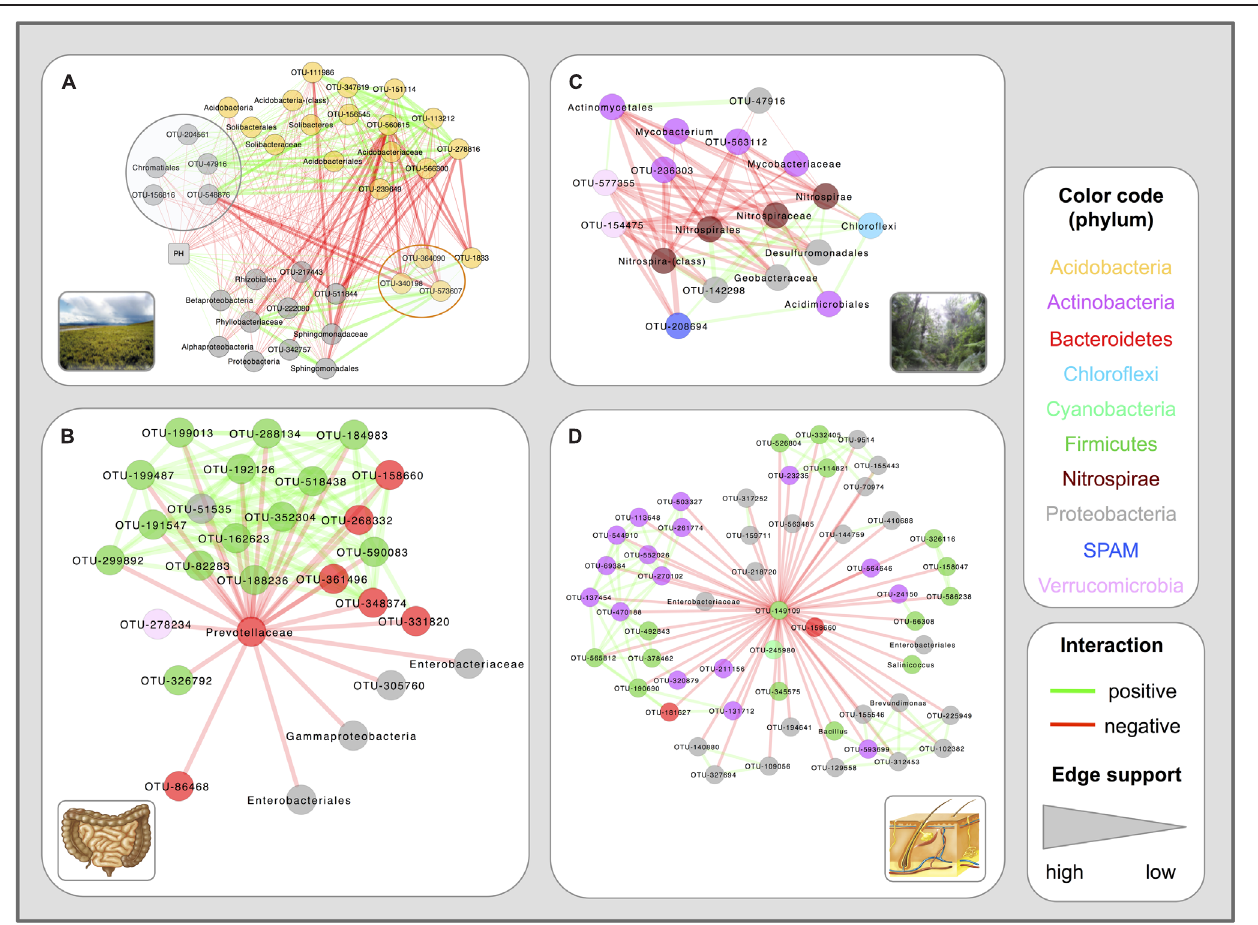
FIGURE 1 | Example networks constructed from QIIME 16S data. Four sub-networks, i.e. node and edge sub-sets from the inferred networks, are shown. The tundra sub-network (A) is dominated by two mutually exclusive clusters consisting of Acidobacteria and Alphaproteobacteria, the first of which is anti-correlated and the second correlated to pH. Notable exceptions to this trend are the Chloracidobacteria (a class within the Acidobacteria, here highlighted with an orange circle) which are positively correlated to pH, and several Rhizobiales (Alphaproteobacteria) and Chromatiales (Gammaproteobacteria) members (gray circle), which are negatively correlated to pH. The gut sub-network (B) reproduces the Prevotella enterotype, including negative correlations of the Prevotellaceae to an Akkermansia and an Escherichia OTU as well as to several Bacteroides OTUs. The moist forest sub-network (C) displays the neighbors of higher-level Nitrospirae representatives, among them the Geobacteraceae, with which Nitrospirales members might cross-feed. The skin sub-network (D) shows the neighbors of a Streptococcus OTU that acts as a negative